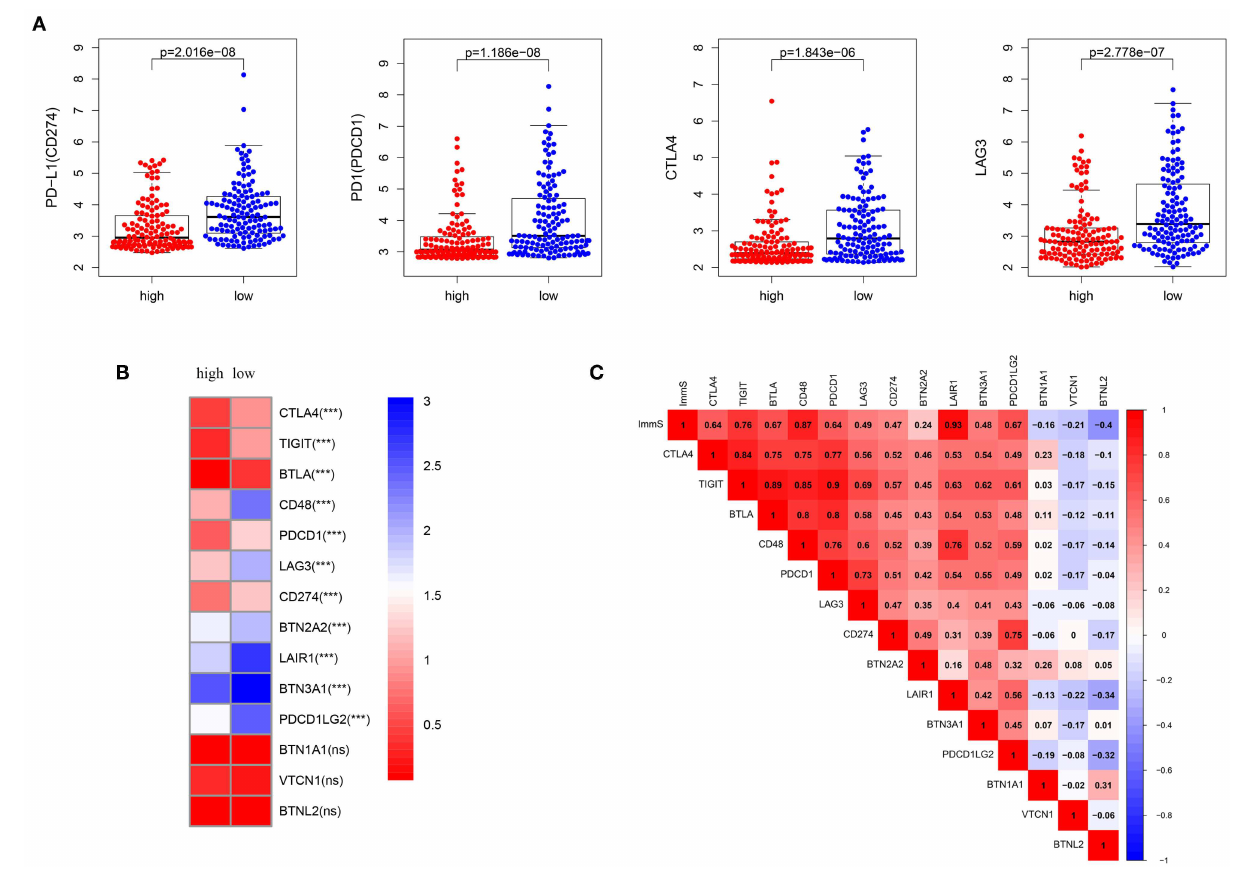
FIGURE 5 | Inhibition of immunity in low-risk patients from TCGA dataset. (A) Differences in common immune checkpoint molecules between high- and low-risk patients. (B) Differences in immune-inhibiting molecules between high- and low-risk patients. (C) Relationships of immune infiltration (immune scores) and immune-inhibiting molecules. Immune infiltration was positively correlated with most immune-inhibiting molecules. ImmS represents the immune scores. *** p < 0.001; ns (not significant), p >